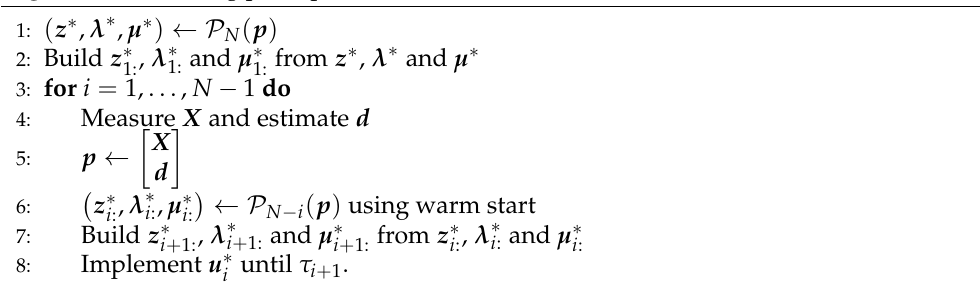
Algorithm 1 Working principle of the ideal NMPC